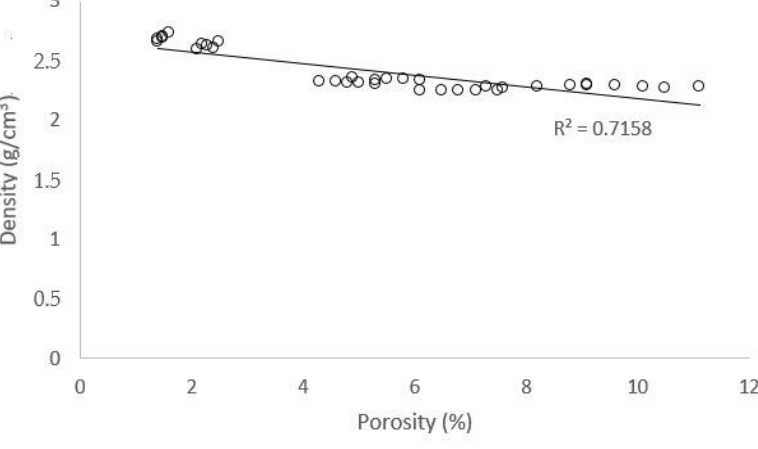
Figure 19. Relationship between porosity and bulk density. Table 4. Uniaxial compression strength, tensile strength, and abrasivity index of the tested sandstones.